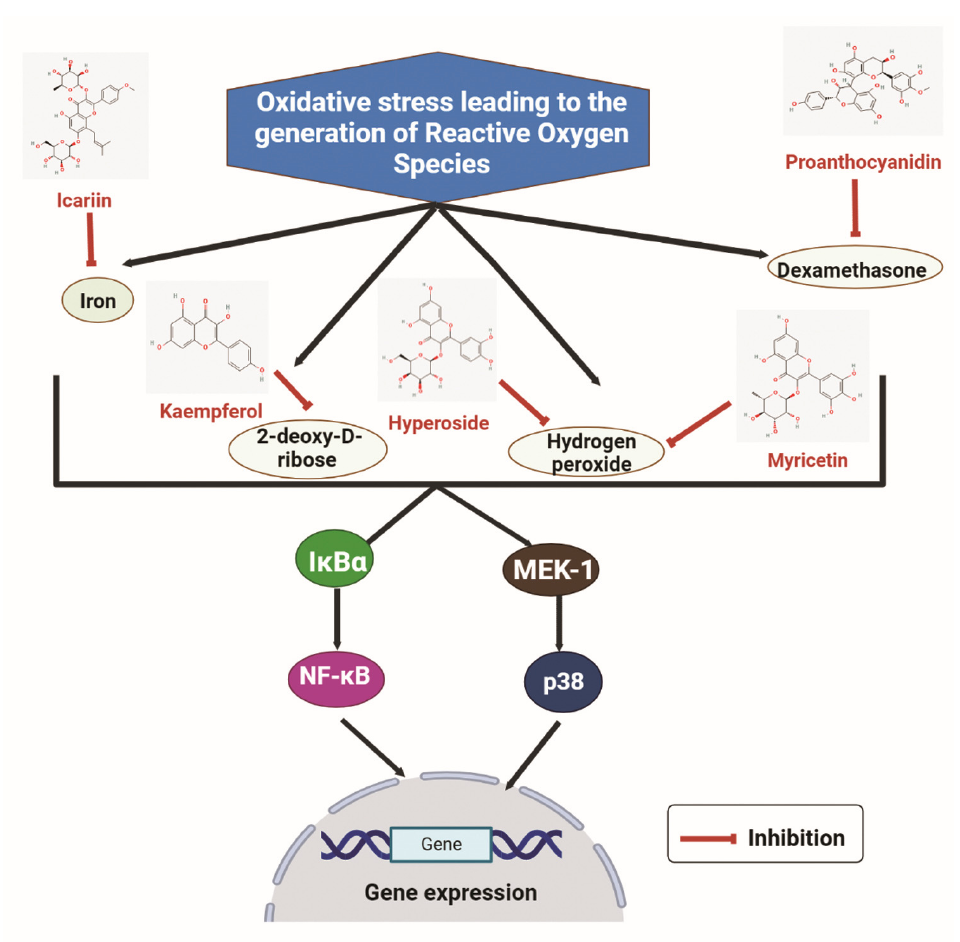
Figure 3. The inhibitory effects of some flavonoids such as icariin, kaempferol, hyperoside, myricitrin and proanthocyanidin on some reactive oxygen species (iron, dexamethasone, hydrogen peroxide, and 2-deoxy-D-ribose). I κ B α : Inhibitor of nuclear factor kappa B alpha; NF- κ B: Nuclear factor kappa B; MEK-1: Mitogen-activated protein kinase-1. (Chemical structures source: PubChem (NCBI, NIH, USA; https://pubchem.ncbi.nlm.nih.gov/) accessed on 7 February 2023, Figures created with BioRender.com).